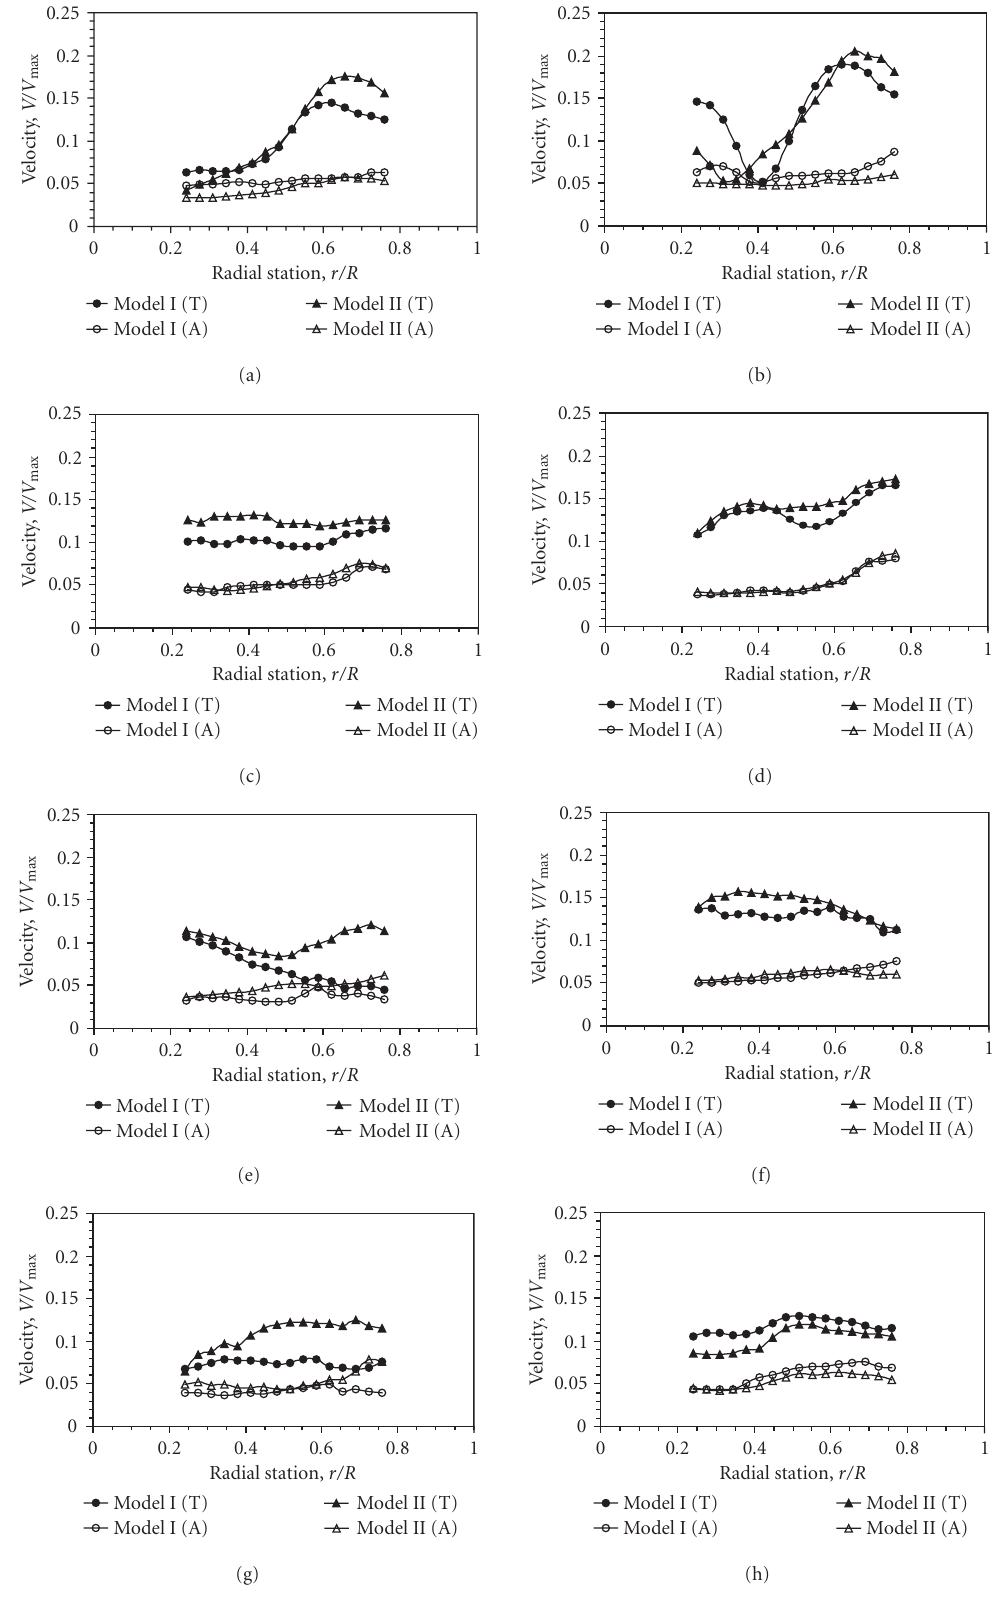
Figure 11: Tangential and axial velocity distributions (T: tangential, A: axial) H 2 /H 1 = 0 . 577, z/Z = 0 . 313. ((a) section 1, (b) section 2, (c) section 3, (d) section 4, (e) section 5, (f) section 6, (g) section 7, and (h) section